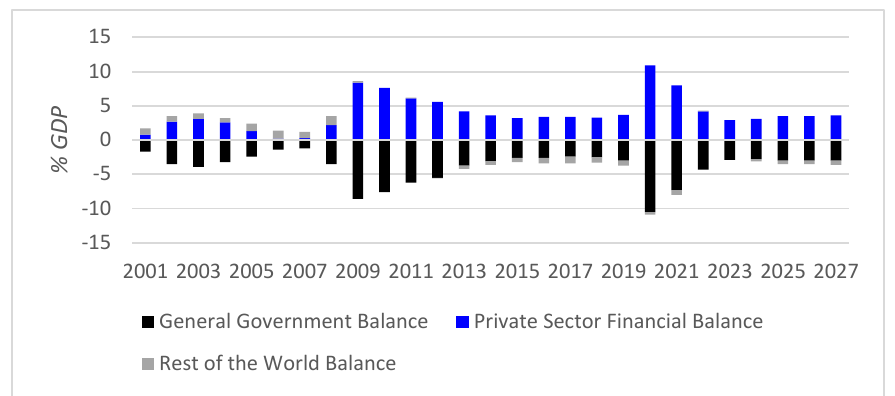
Figure 3. Advanced economy general government, private and foreign sector financial balances. Data: IMF [40].